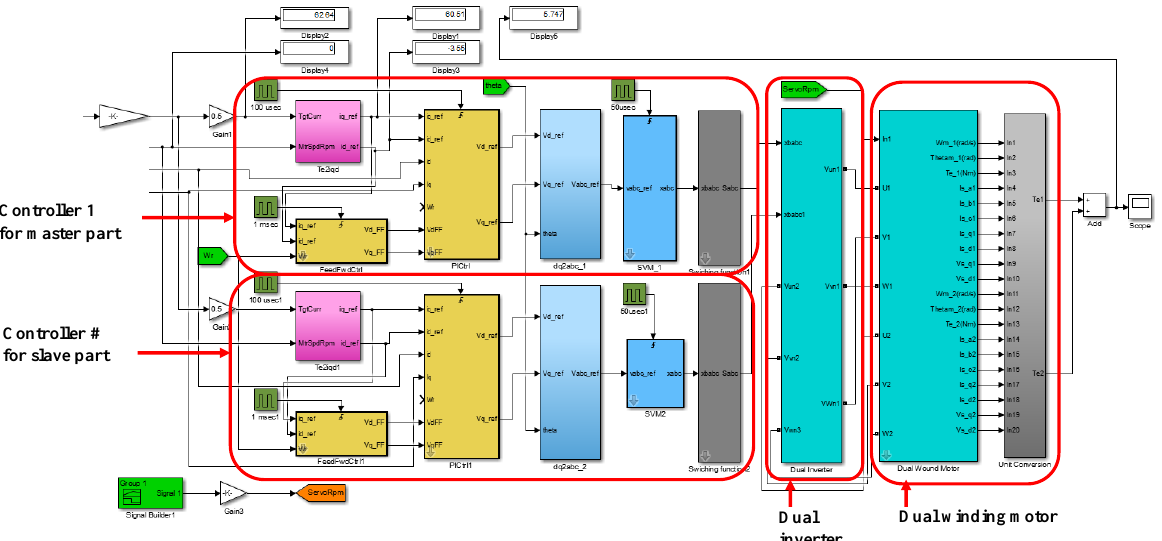
Figure 10. Current vector control strategy for DWM using Simulink.